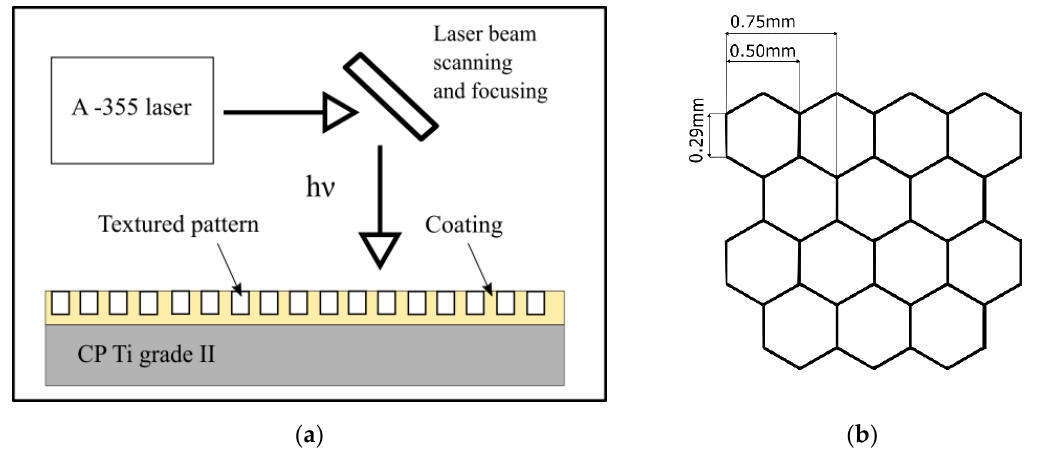
Figure 2. Schematic diagram of ( a ) laser micromachining system and ( b ) the honeycomb-like pattern of laser texturing. Table 3. Laser texturing process parameters.